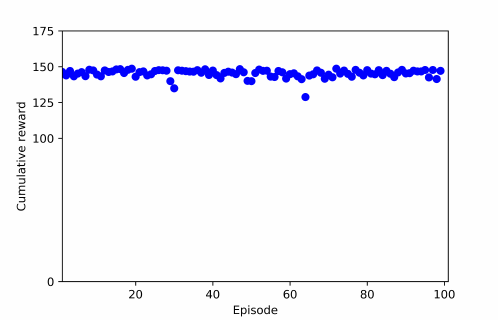
Figure 38. Test Result for Case 2.1 (Without TL).